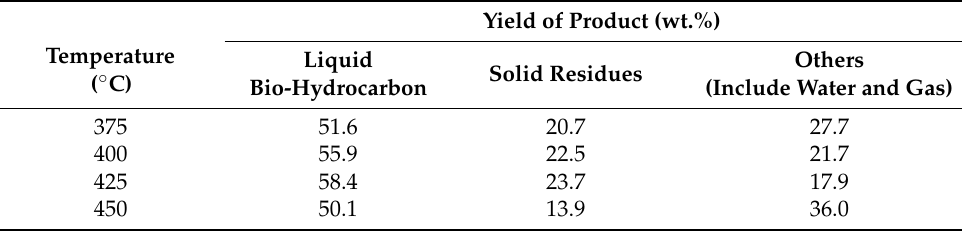
Table 2. Material balance of M-mix soap pyrolysis